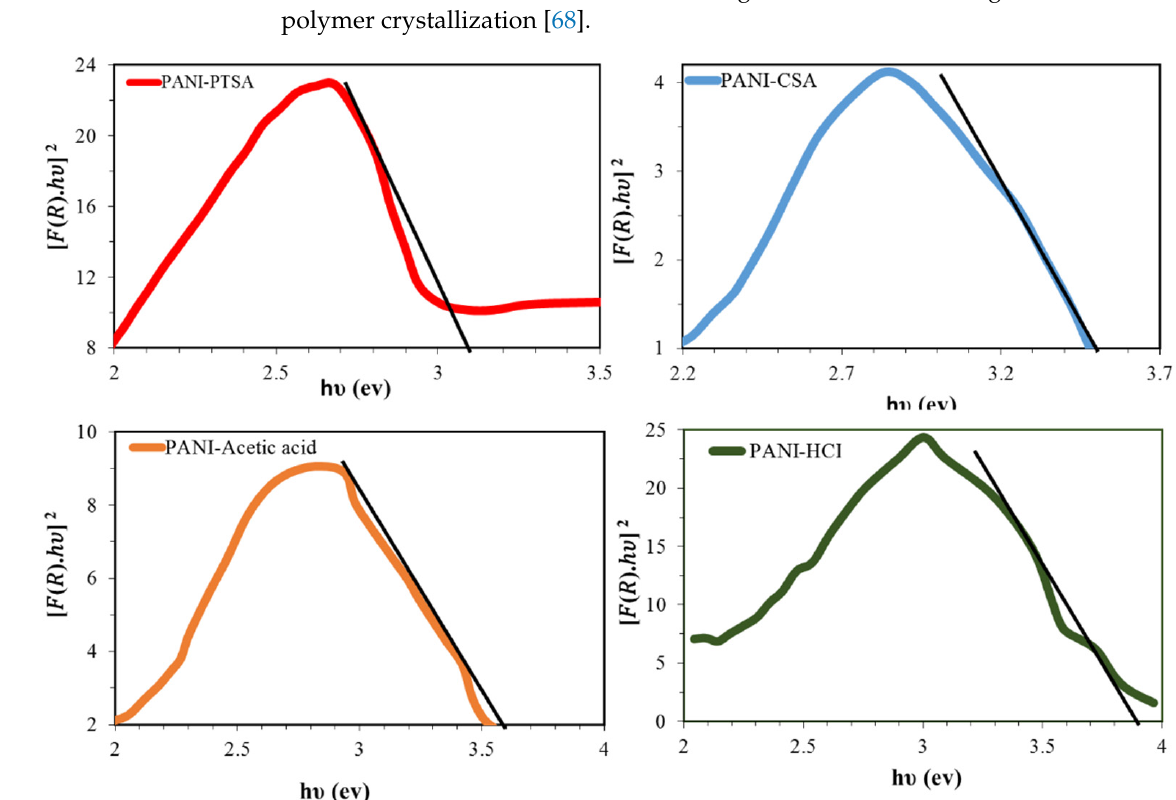
Figure 5. Bandgap curves as optical properties of the PANI samples.